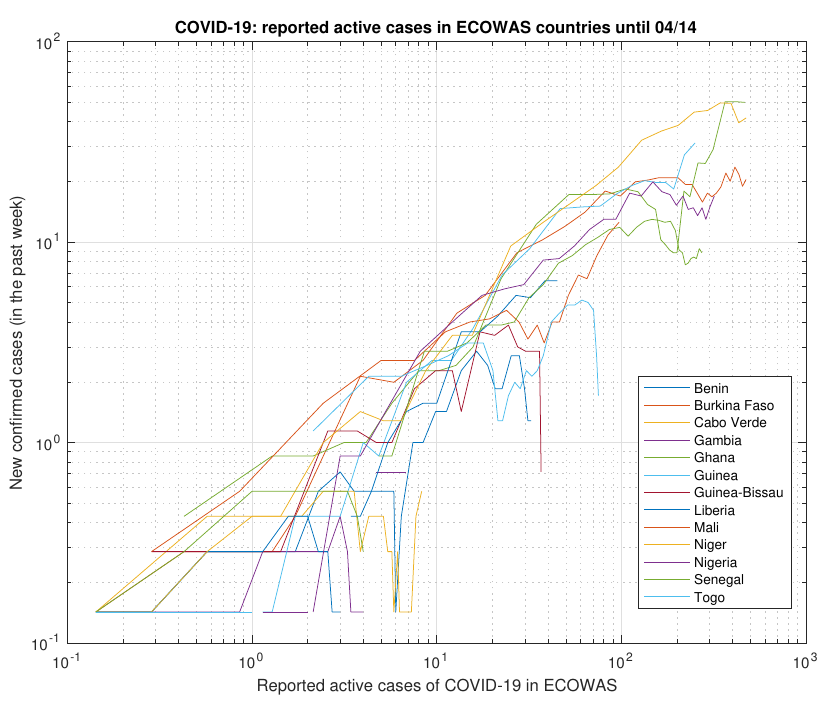
Figure 46. Selected COMESA countries